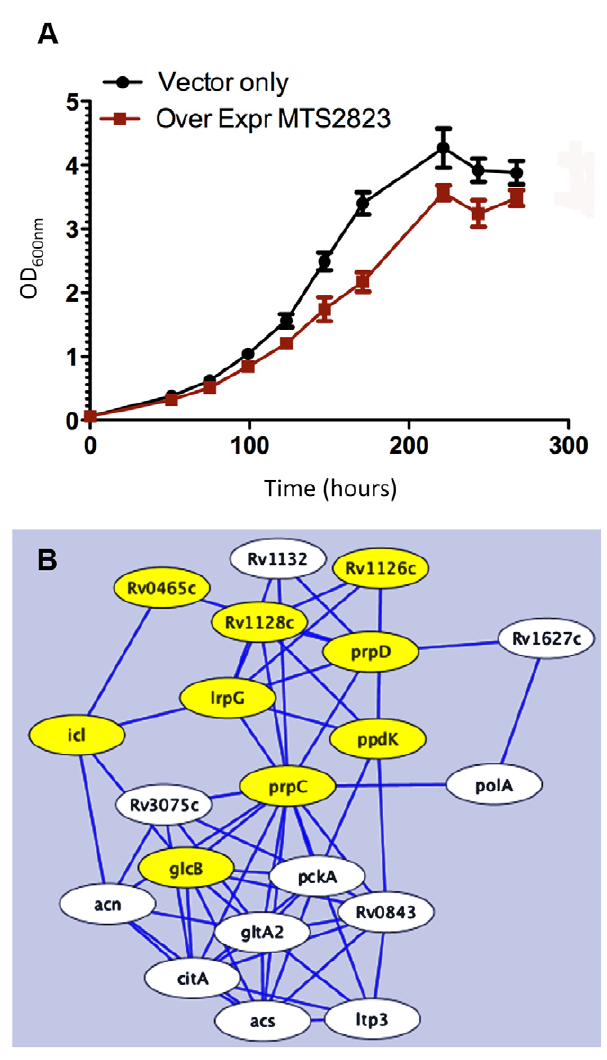
Figure 8. Over-expression of MTS2823. Panel A shows in vitro growth curves for M. tuberculosis H37Rv over-expressing MTS2823 compared to M. tuberculosis H37Rv harbouring the empty vector. Panel B: Hypothetical protein association network centered around prpC . The figure was created using the STRING database [47]. Proteins are shown as nodes and associations as lines. The methyl citrate genes prpC , prpD and their regulator, lrpG , are shown along with their immediate first neighbours; genes down-regulated between 2- and 2.5-fold are shown in white and genes down-regulated 2.5-fold or more are shown in yellow. Network construction and visualisation was performed in Cytoscape [77].